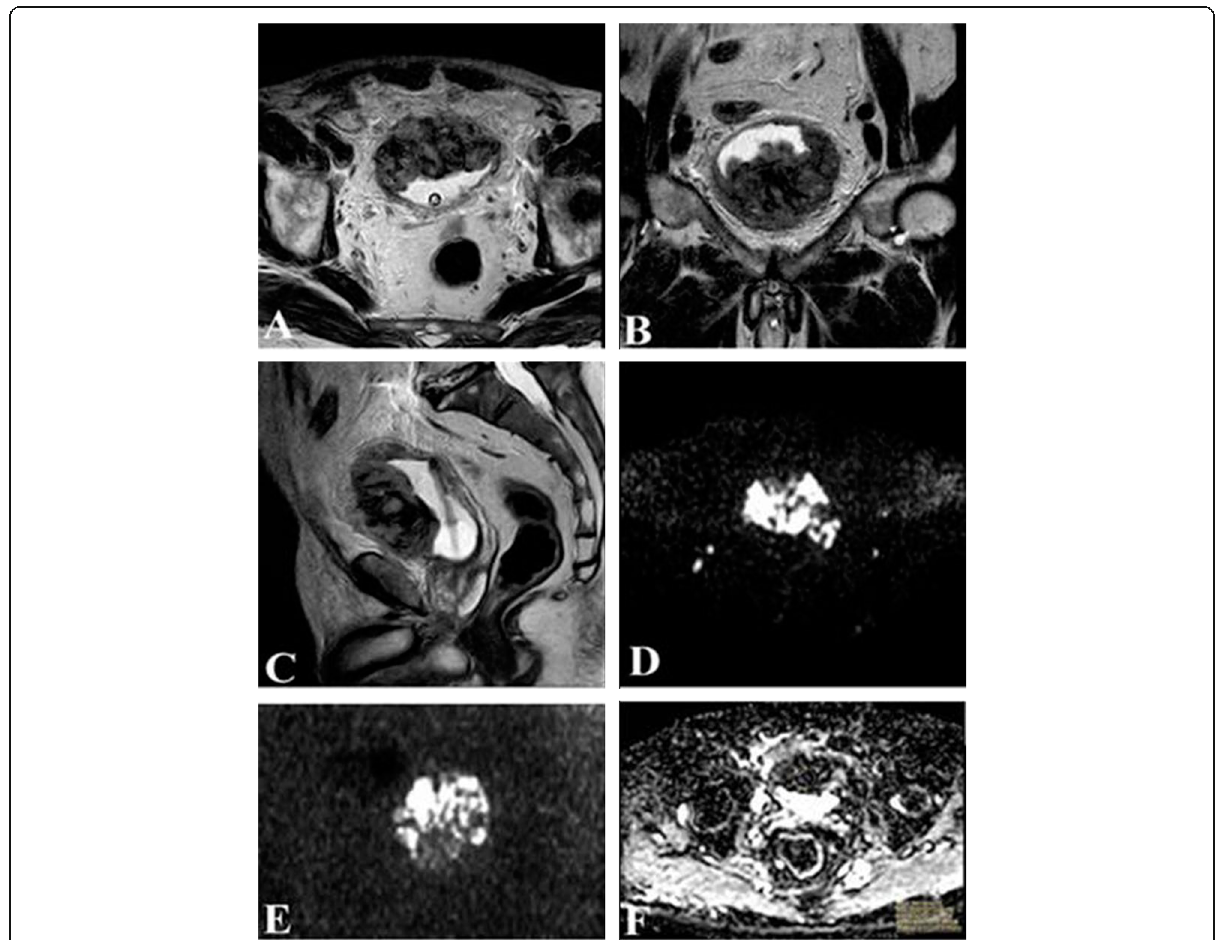
Fig. 5 An intravesical hypointense soft tissue mass is seen arising from anterior wall, dome and both lateral walls with infiltration of perivesical fat. a Axial HR T2 image, b coronal HR T2 image, c sagittal HR T2 image, d axial DWI (b 1400) image, e coronal DWI image (b 1400), and f axial ADC map with ADC measured within lesion (0.23 × 10 − 3 mm2/s). Pathologically proved small cell carcinoma T3,